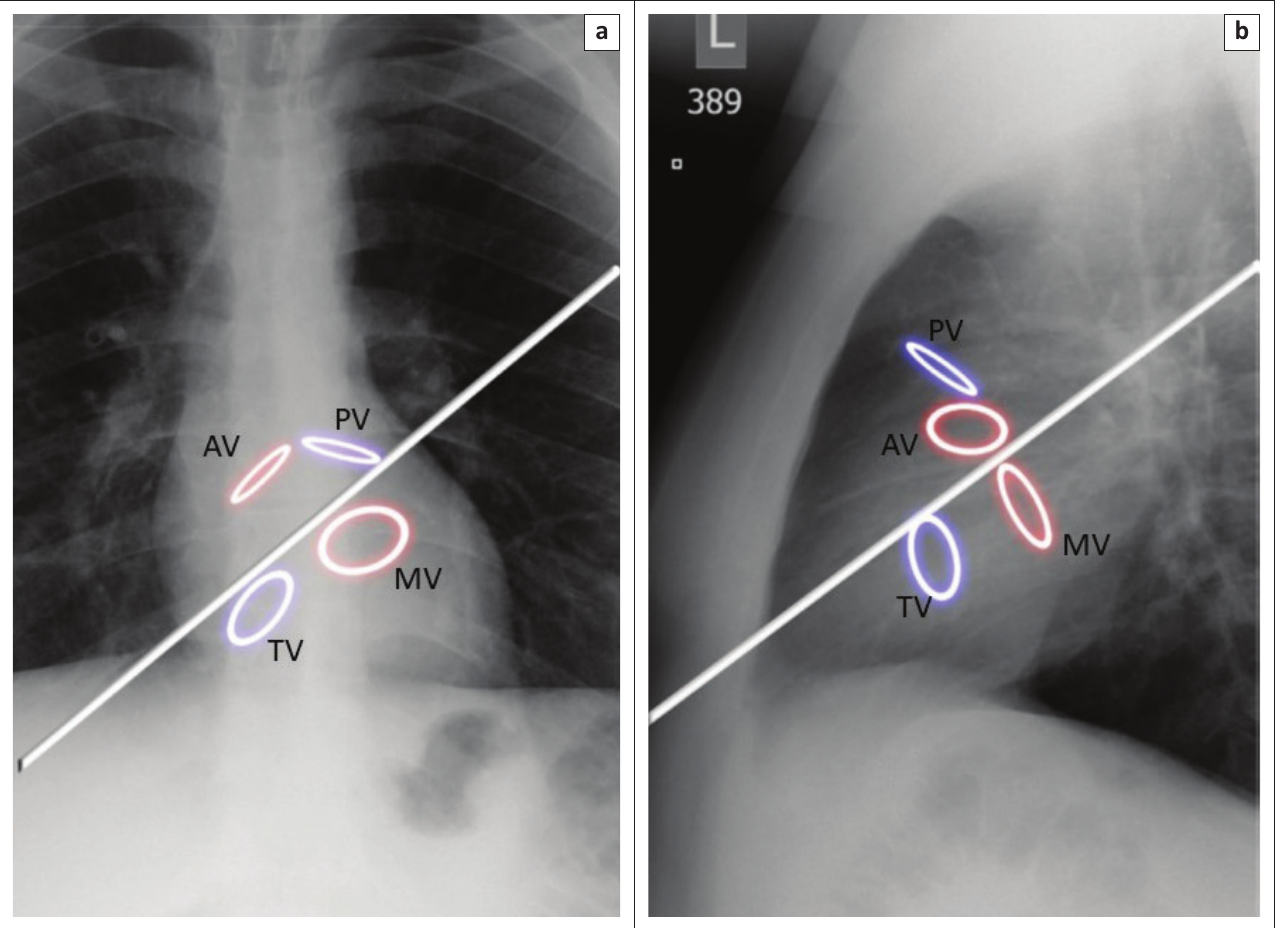
FIGURE 13: By drawing an imaginary line extending from the left atrial appendage to the right cardiophrenic angle on a posterior–anterior (a) chest radiograph and an imaginary line from the carina to the cardiac apex on the lateral view (b), the cardiac valves can be identified.